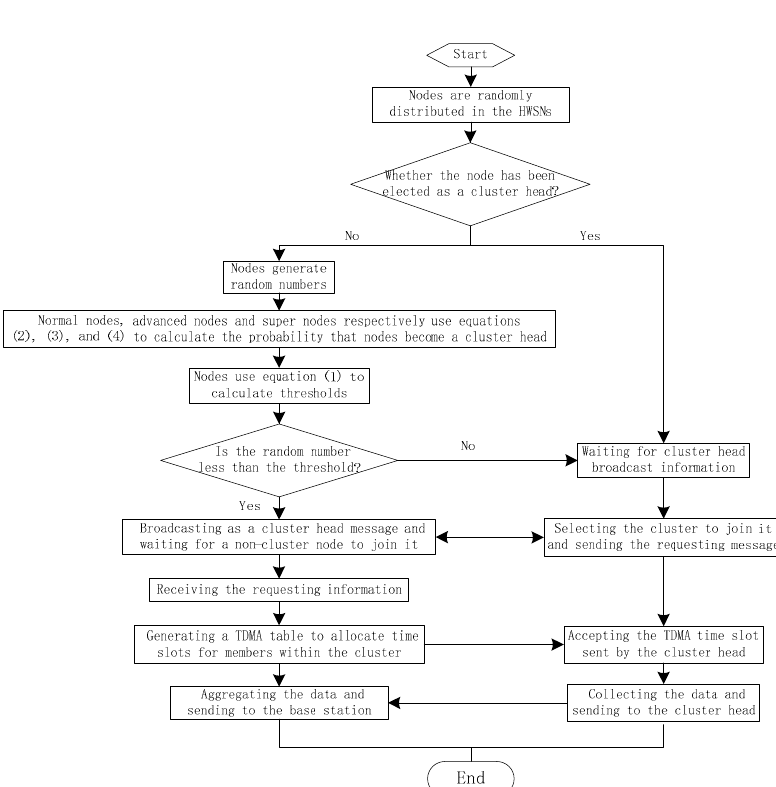
Figure 1. The flow diagram of Threshold-Sensitive Stable Election Protocol (TSEP) algorithm. HWSN: heterogeneous wireless sensor network; TDMA: time division multiple access.